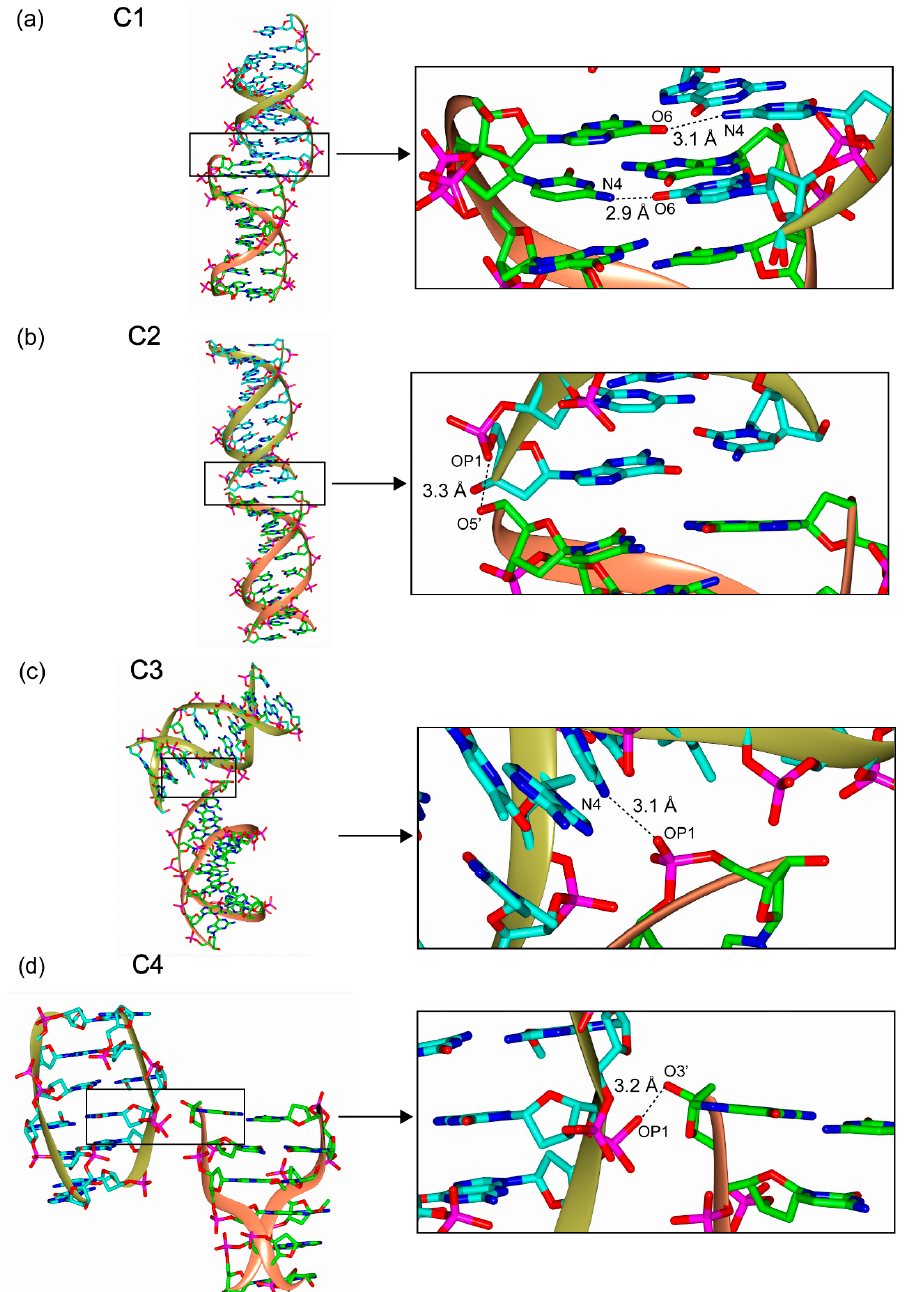
Figure 2. Categories of DNA crystal packing interactions (DXPIs). Four categories of DXPI are defined based on the intermolecular H-bonds among the atoms in the terminal end and mid-region. The following representative structures and their interactions are displayed to explain the intermolecular H-bond in each category; ( a ) C1: intermolecular H-bond between bases (O6 vs N4) present in the terminal ends of symmetry equivalent double-stranded oligodeoxynucleotides (dsODNs) (PDB ID 1ENN), ( b ) C2: intermolecular H-bond between the terminal end phosphate (OP1) and terminal end sugar (HO5’) (PDB ID 3IXN), ( c ) C3: intermolecular H-bond between the terminal end phosphate (OP1) and mid-region base (N4) (PDB ID 3IXN), and ( d ) C4: intermolecular H-bond between mid-region phosphate (OP1) and terminal end sugar (HO3´) (PDB ID 1D24). The atoms involved in the intermolecular H-bond are labeled with respective bond lengths in block dotted lines. The backbones (coral) and bases (cyan) of the reference structures and their symmetry equivalents (backbone: yellow, and base: green) are represented in ribbon and stick diagrams. The detailed definition of each interaction category is explained in Table